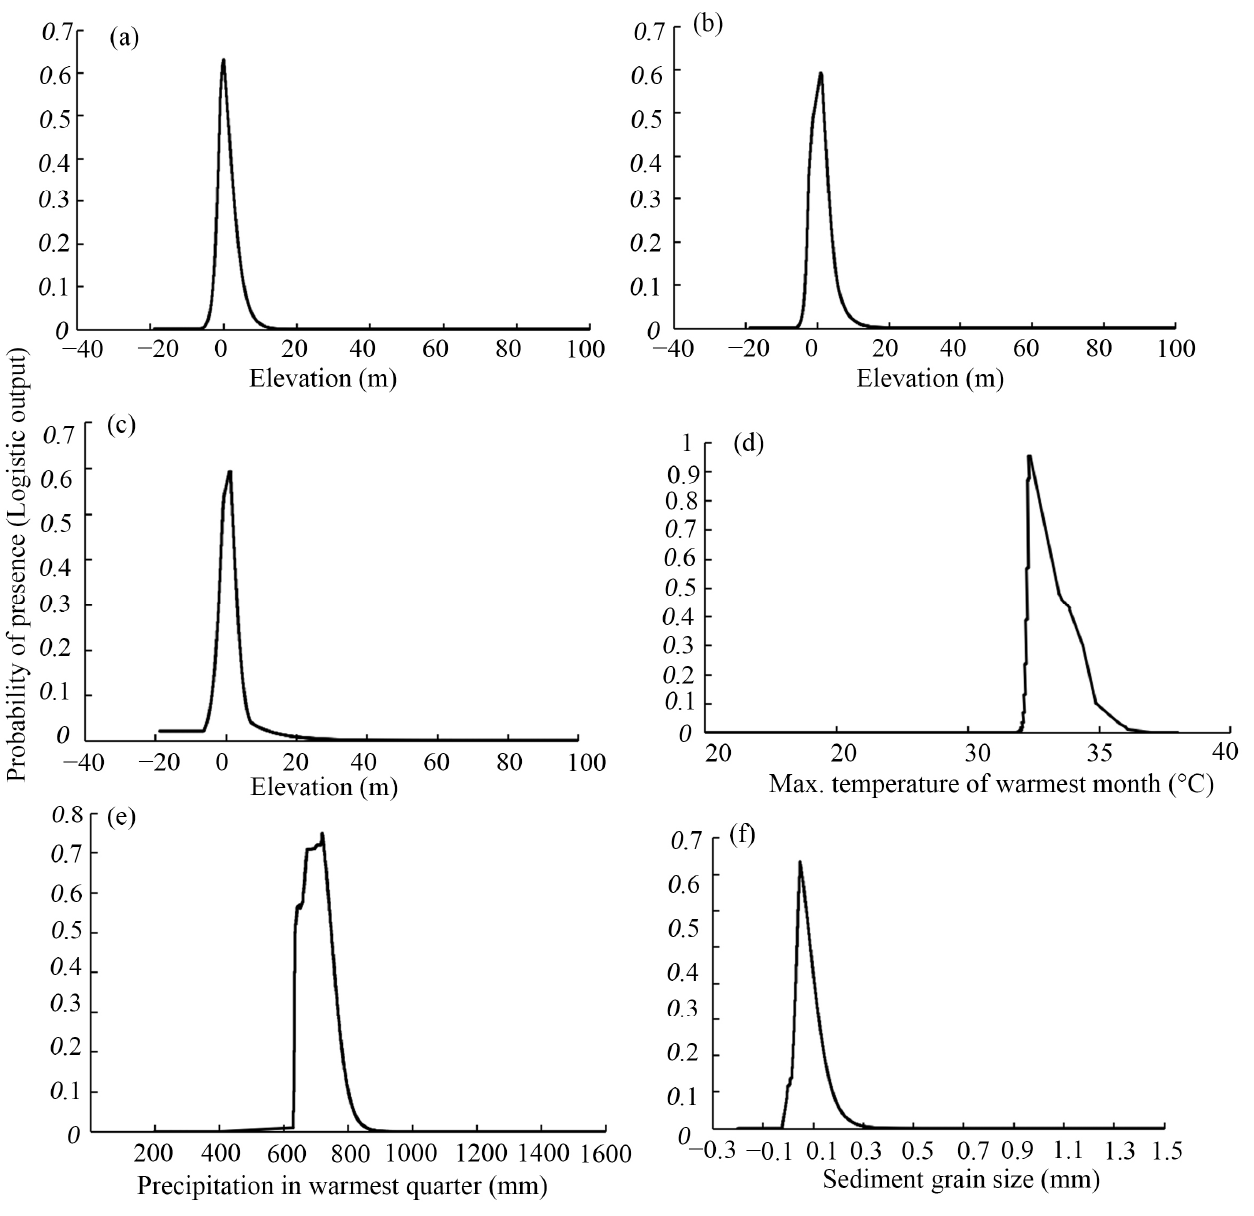
Figure 10. The response curves of environmental variables for ( a ) A. marina , ( b ) A. corniculatum , ( c ) K. obovata , ( d ) B. gymnorrhiza , ( e ) R. stylosa , and ( f ) A. ilicifolius (entry definitions are the same as in Figure